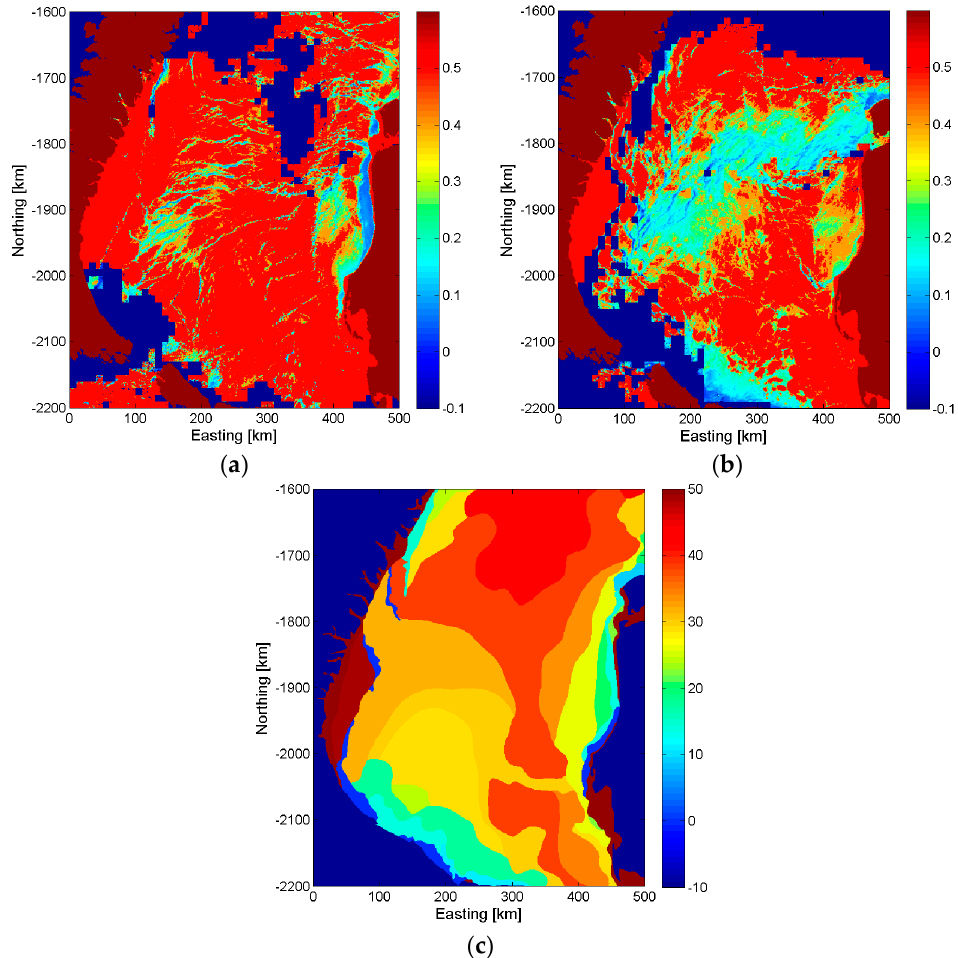
Figure 16. Daily sea ice thickness chart ( a ) on 23 January 2016 and ( b ) 24 January 2016 over the southern Kara Sea. ( c ) AARI ice chart on 26 January 2016 showing average sea ice thickness for each chart polygon. Thin ice area in the middle of ( b ) is very likely due to the undetected thin clouds or fog.